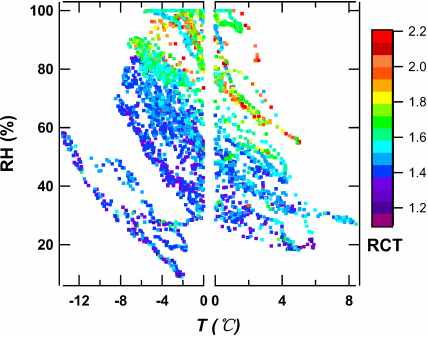
Figure 8. RCT as a function of temperature and RH.